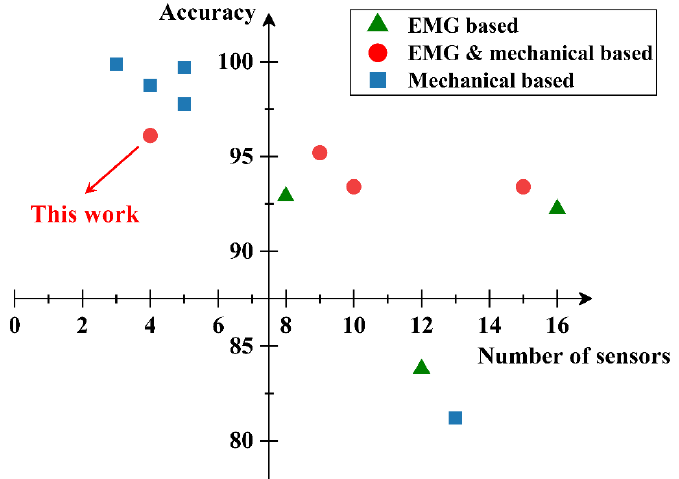
Figure 1. The numbers and categories of the applied sensors and the classification accuracy of relevant studies. “electromyography-based (EMG-based)” or “Mechanical-based” mean only the EMG signals or mechanical signals, e.g., inertial measurement units (IMUs), ground reaction force (GRF) sensors or attitude and heading reference system (AHRS), are utilized in the study. “EMG & mechanical-based” means the fusion of the EMG and other mechanical signals was applied.